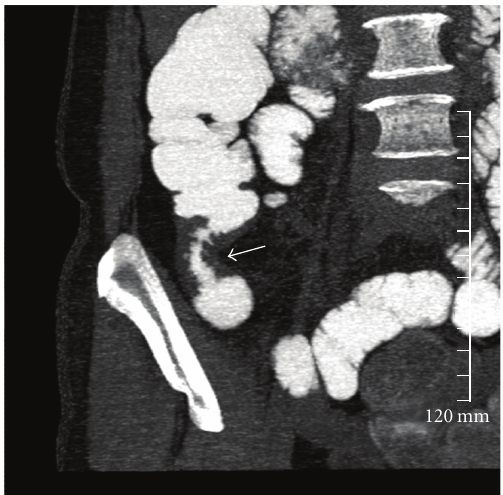
Figure 2: Coronal thick-slab-reconstructed image in a patient with documented Crohn’s disease with a chronic stricture causing low- grade obstruction (white arrow).